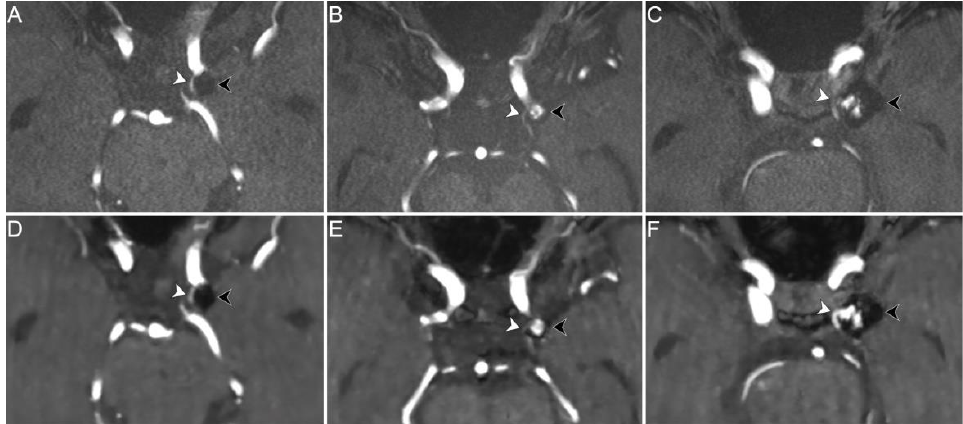
Figure 4. PI (upper row) and CS (lower row) TOF MRA images of three different patients exemplifying differences in performance between the two sequences in the depiction of parent vessel and vessels coursing in close proximity to the aneurysm dome. Axial PI TOF MRA ( A ) and CS TOF MRA ( D ) of a coiled aneurysm of the left supraclinoid internal carotid artery (black arrowheads) without signs of recanalization (class I); the proximal portion of the left anterior choroidal artery, which